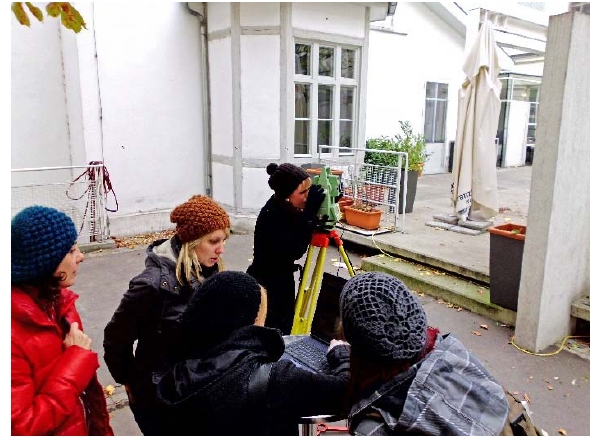
Figure 6. Students first contact with a total station accompanied by teaching staff and tutors, courtyard of TU Wien